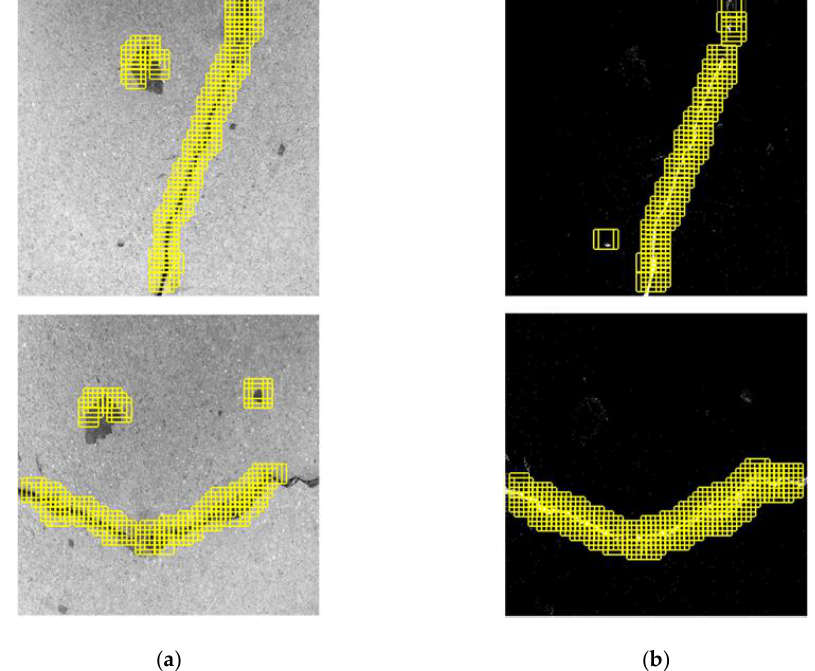
Figure 25. Results of crack position detection (CPD) based on ( a ) the original CPD and ( b ) the MLP–CNN, with stains in the background.